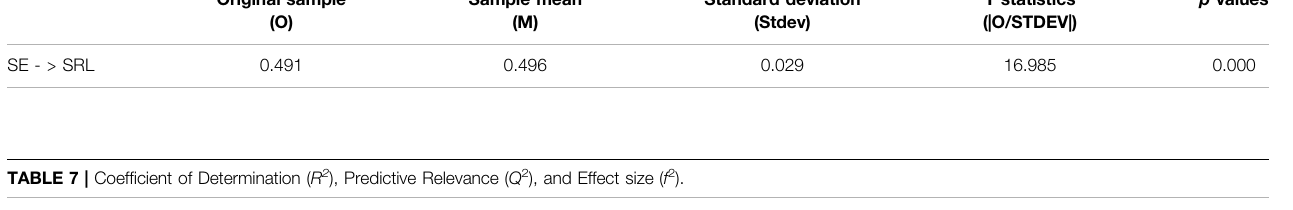
Original sample (O)